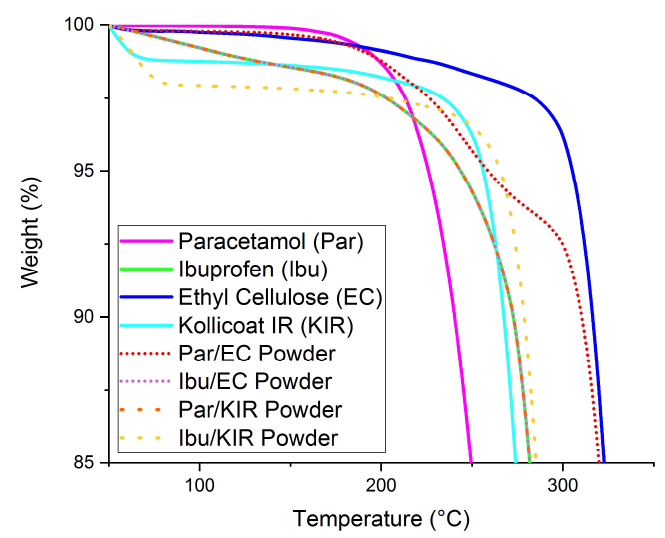
Figure 2. Thermogravimetric analysis (TGA) results of the raw drugs, polymers and powders prior to printing.